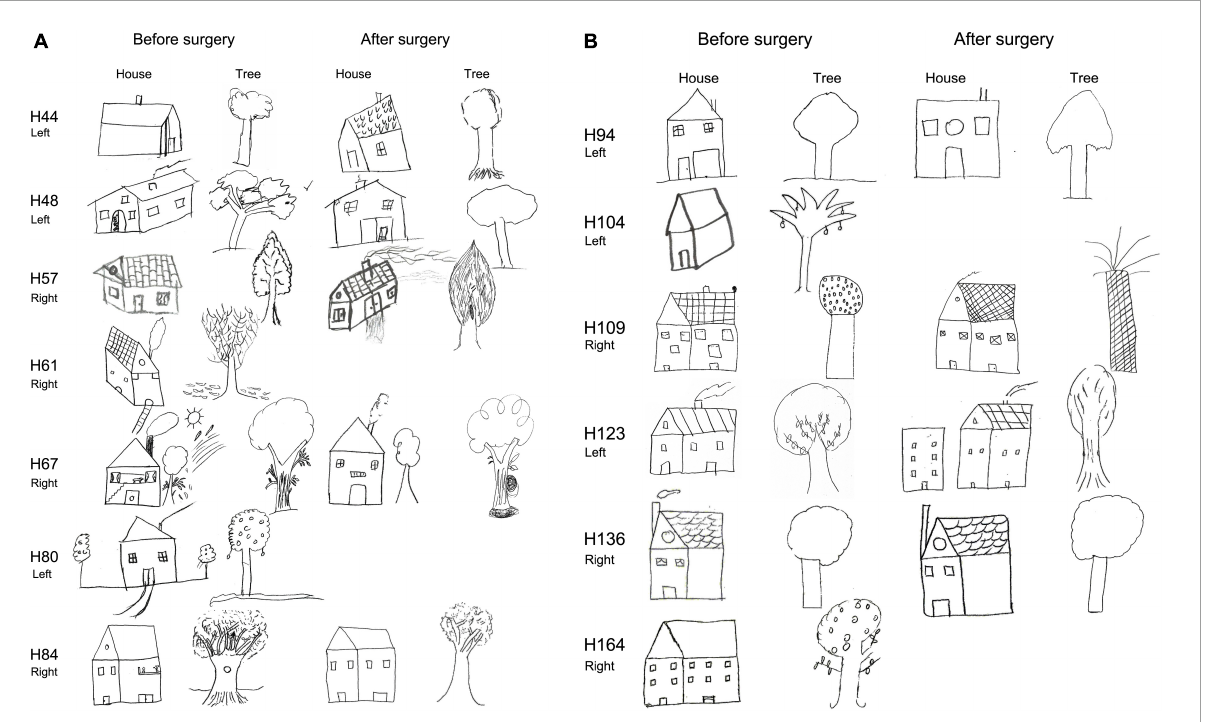
FIGURE9 (A) House and tree drawings of the H-T-P test (before and after surgery) performed by HS-patients that became seizure-free patients after surgery. All patients except H44 and H61 were right-handed. Patients H61 and H80 were not evaluated after surgery. Note rotations (H44, house after surgery) or strange elements (H67; house before surgery; tree before and after surgery) or transparencies (H44 tree after surgery; H84 tree before surgery). The size of the original drawings was not considered. (B) House and tree drawings of the H-T-P test (before and after surgery) performed by HS-patients that became seizure-free after surgery. All patients were right-handed. Note bi-dimensionality in most patients when drawing the house. Patients H104 and H164 were not evaluated after surgery. The size of the original drawings was not